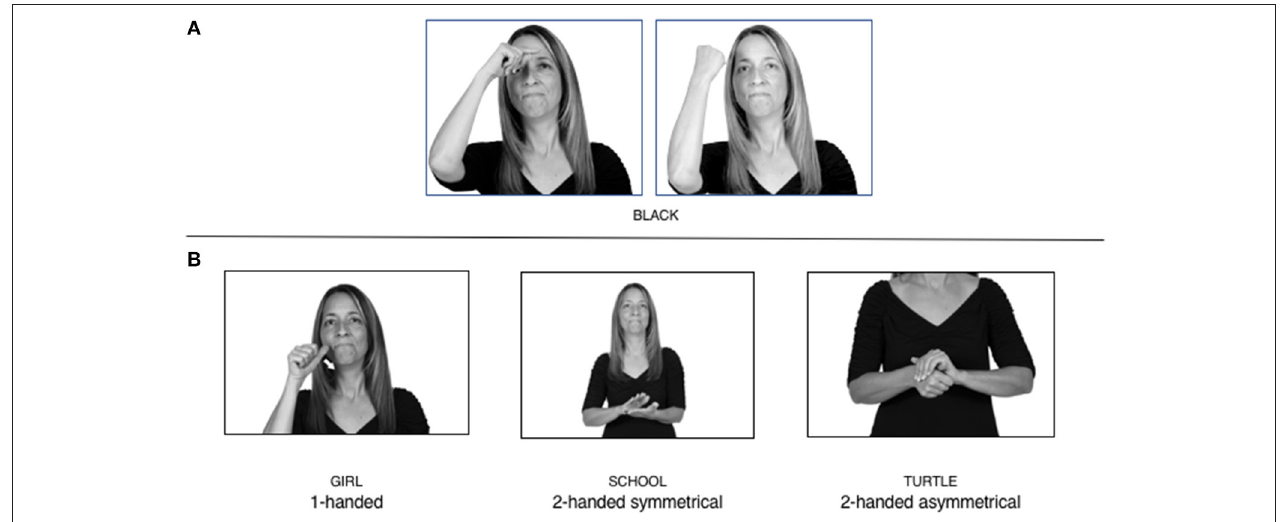
FIGURE 1 | The ASL signs BLACK (A) and the signs GIRL , SCHOOL , and TURTLE (B) . All photographs, copyright Aaron Shield and Richard P. Meier, are reproduced here and in Table 1 with written permission of the model.